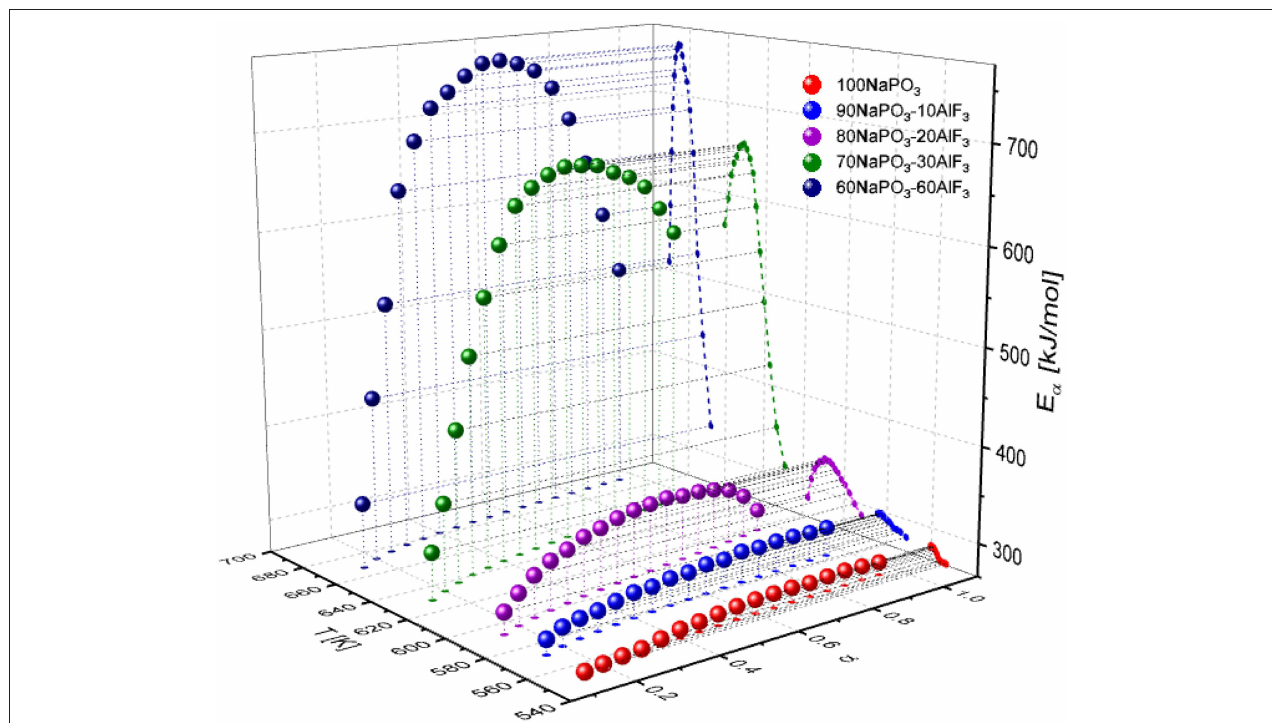
FIGURE 11 | Conversion and temperature dependence of the activation energy for NAPF [(100-x)NaPO 3 –AlF 3 , x = 0, 10, 20, 30, 40] glasses.